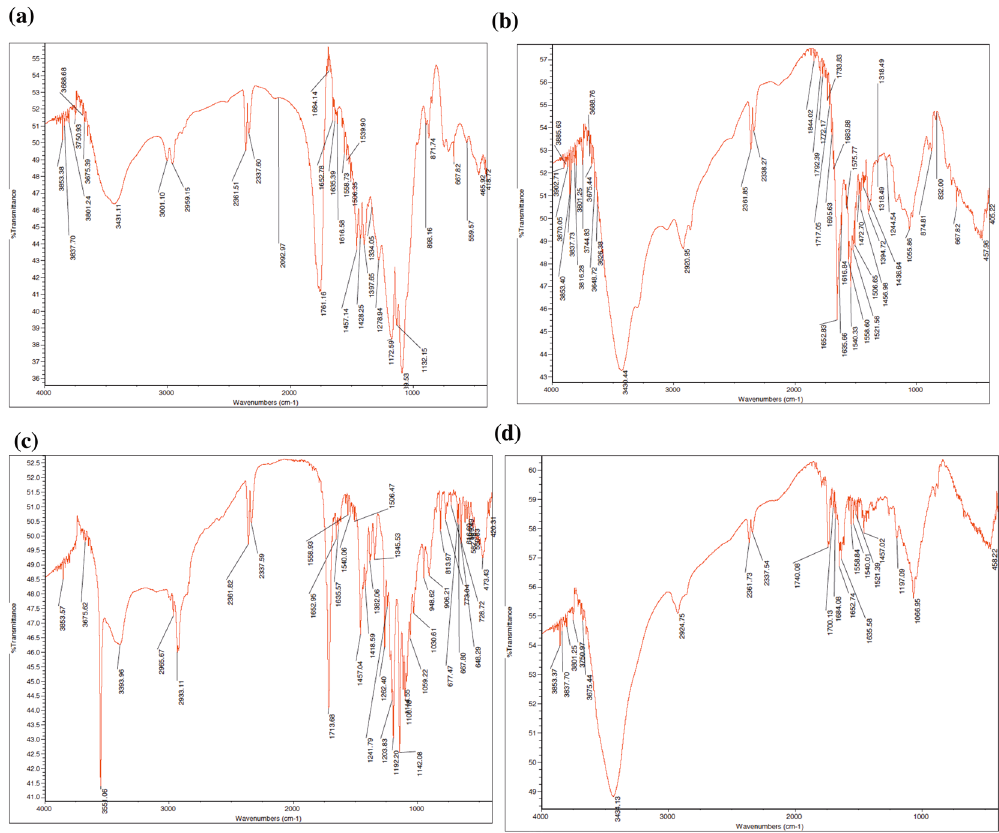
Figure 3. FTIR spectroscopy for investigation of melatonin-PLGA-PLL-Trolox nanoparticles. FTIR spectra analysis was performed to confirm the conjugation of PLL and Trolox to the surface of PLGA nanoparticles. (a) PLGA alone, (b) PLL alone, (c) Trolox and (d) PLGA-PLL-Trolox nanoparticles.